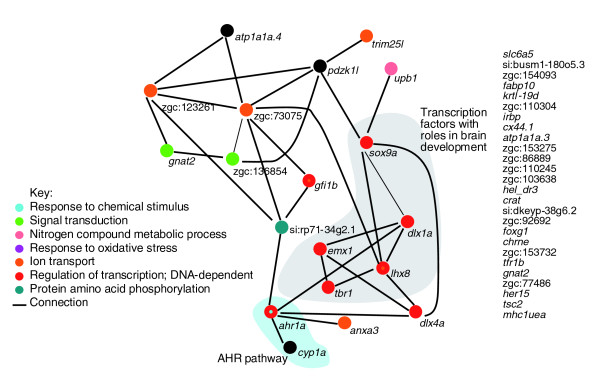
Network view of 18 genes from the reward pool functionally linked by the ZFISHDB database. Nodes are connected if functional interactions between the genes are provided by the cluster of orthologous genes (COG) mode of the STRING database. The GO terms listed are not exhaustive. The genes that have a mouse homologue and were thus included in the analysis, but which were not linked to other genes in the pool, are listed separately on the right. In addition, her15, tsc2 and mhc1uea, for which the program did not find suitable mouse homologues, but for which we manually checked for associates with the other genes in the network, are also listed.